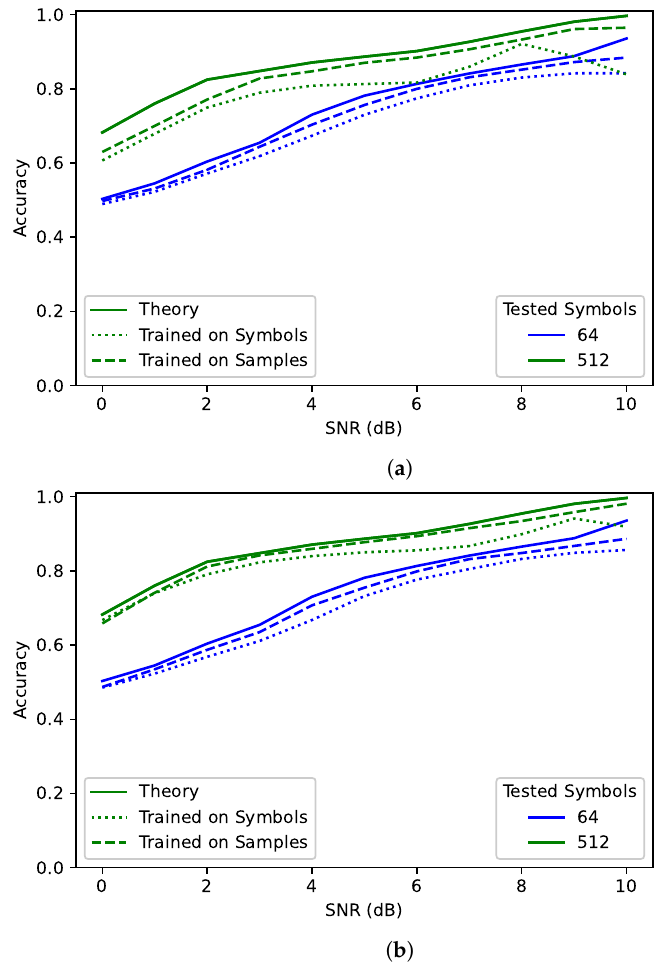
Figure 2. A comparison between the performance upper bound and the best samples and symbols networks trained on ( a ) 64 symbols and ( b ) 512